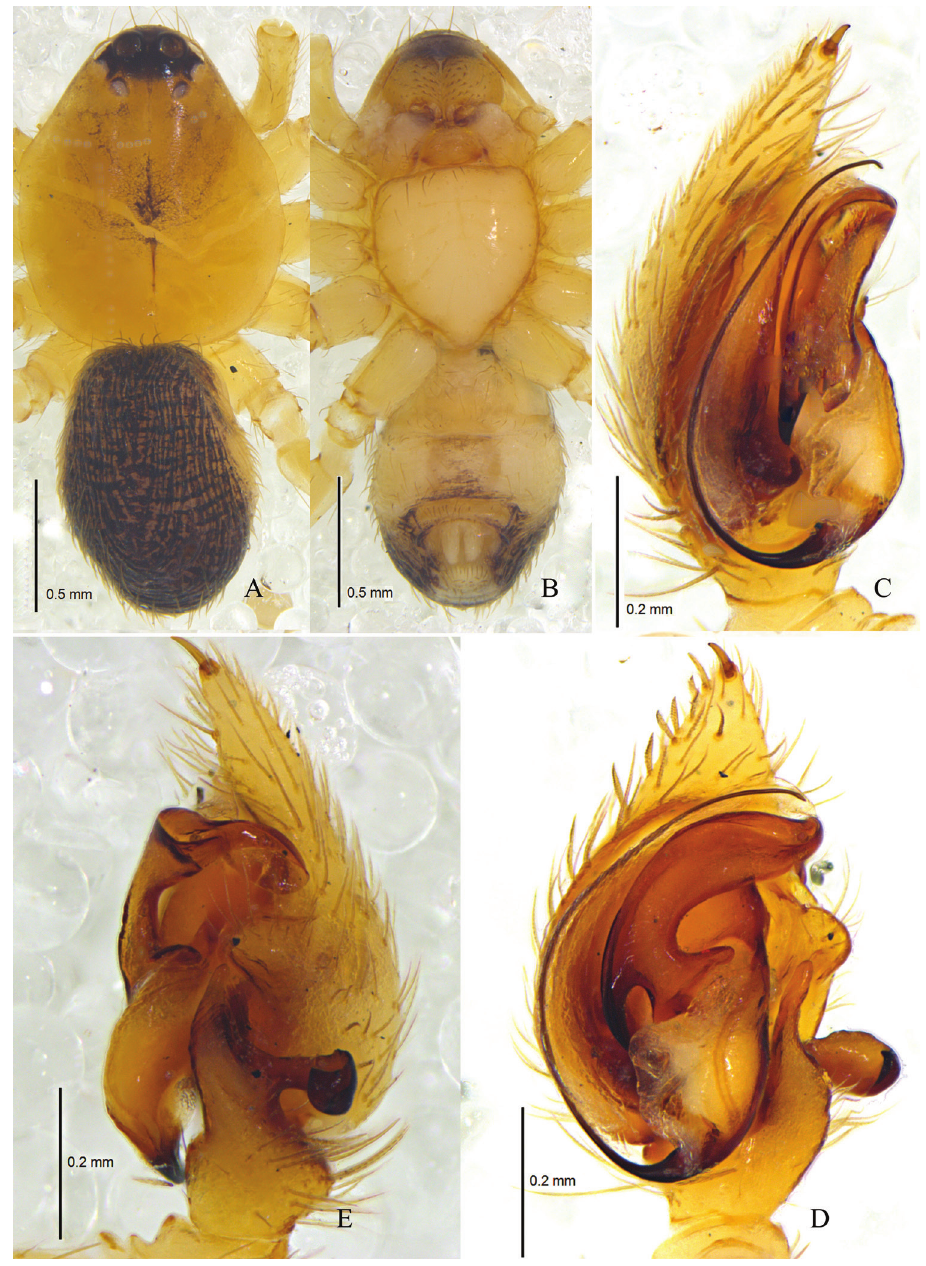
Figure 4. Zodarion planum sp. n., male holotype ( A–E ) A, B Habitus ( A dorsal view B ventral view) C–E Left male palp ( C prolateral view D ventral view E retrolateral